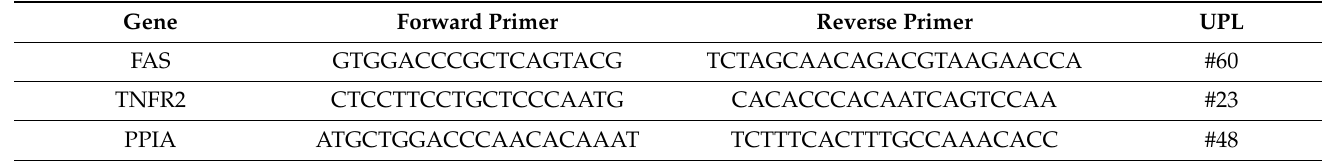
Table 2. Primers and probes used for the